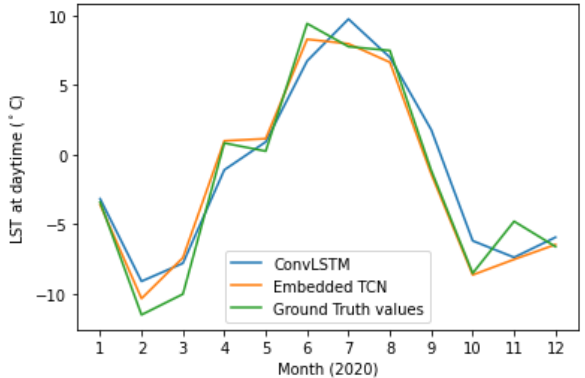
Figure 15. Timeseries of actual and predicted LST over different months of 2020.